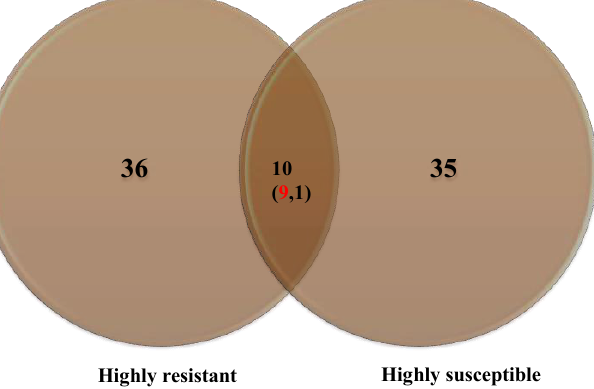
SC—susceptible check; HS—highly susceptible; HR—highly resistant; RC-resistant check. A maximum number of metabolites (36) were identified in HR compared to HS (35), with ten common metabolites (Figure 4).